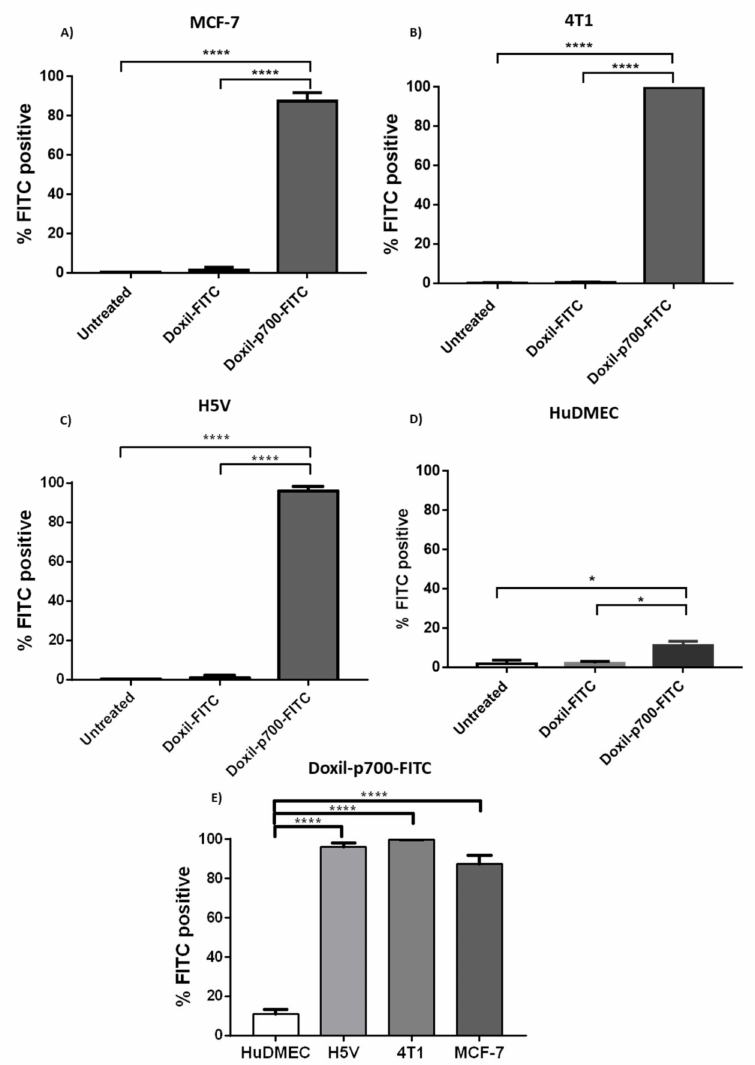
Figure 2. The effect of coupling p700 peptide on the binding of Doxil to cells. Bar charts showing comparative flow cytometric data for the binding of Doxil-FITC or Doxil-p700-FITC to ( A ) MCF-7; ( B ) 4T1; ( C ) H5V or ( D ) HuDMEC. ( E ) Relative binding of Doxil-p700-FITC to the above cell lines. Percentages relate to numbers of cells with a fluorescence intensity above that of untreated cells. Data are means ± SEM, n = 3 (**** p < 0.0001, * p < 0.01 indicates significance, one-way ANOVA, multiple comparison